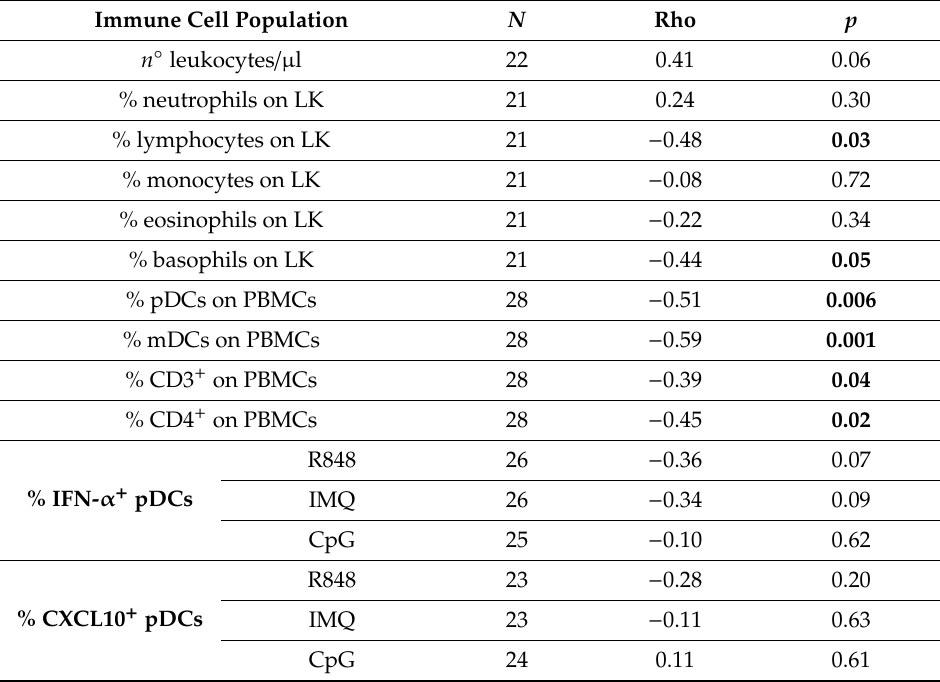
Table 4. Correlation between tumor burden (mm) and peripheral blood immune cells of the MM patient cohort at baseline (T0; N =